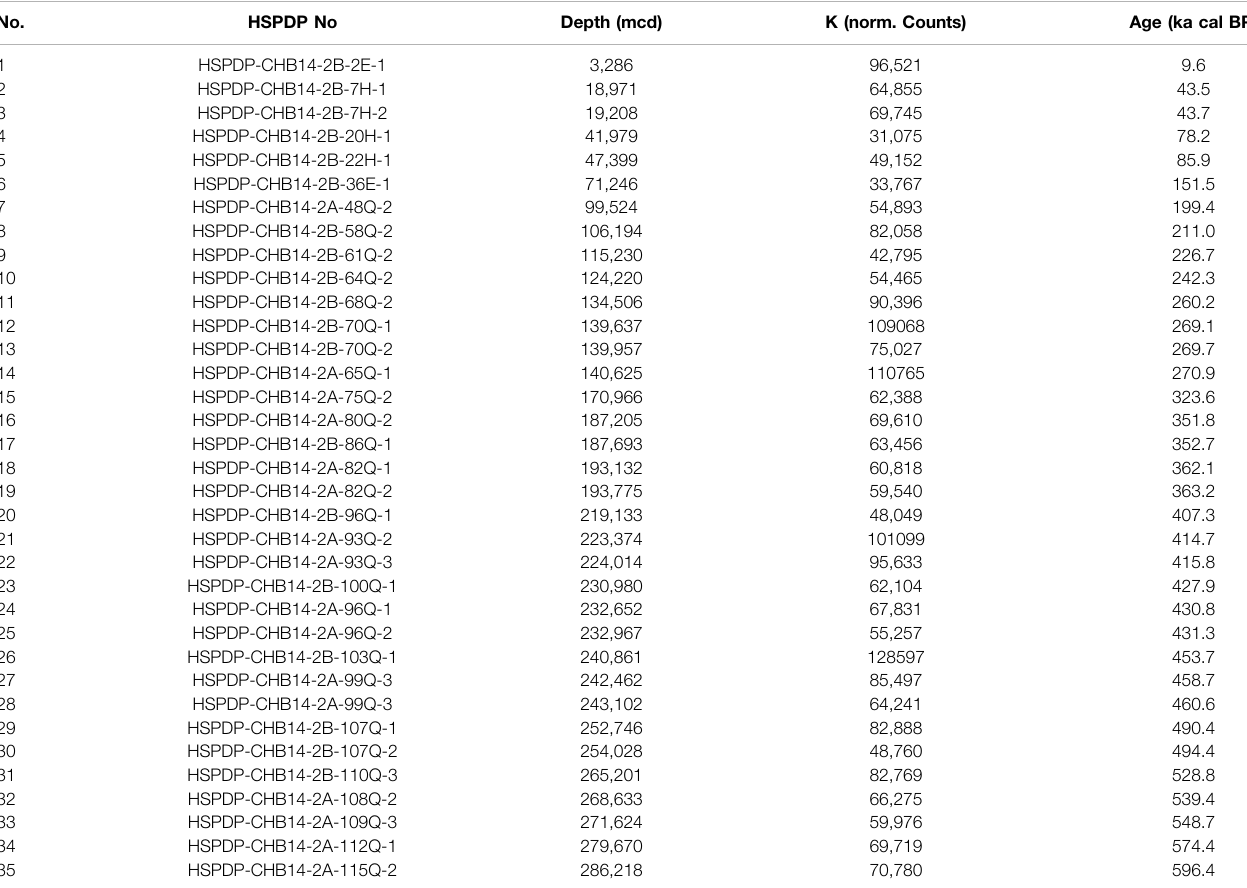
TABLE 1 | Overview of all spectrally measured CHB14-2 samples with information on sample ID, core depth (midpoint) in meters composite depth (mcd), and potassium counts (normalized counts per 10 s) (Trauth et al., 2020) and interpolated sediment age in ka cal BP (Roberts et al., submitted). No. HSPDP No Depth (mcd) K (norm.